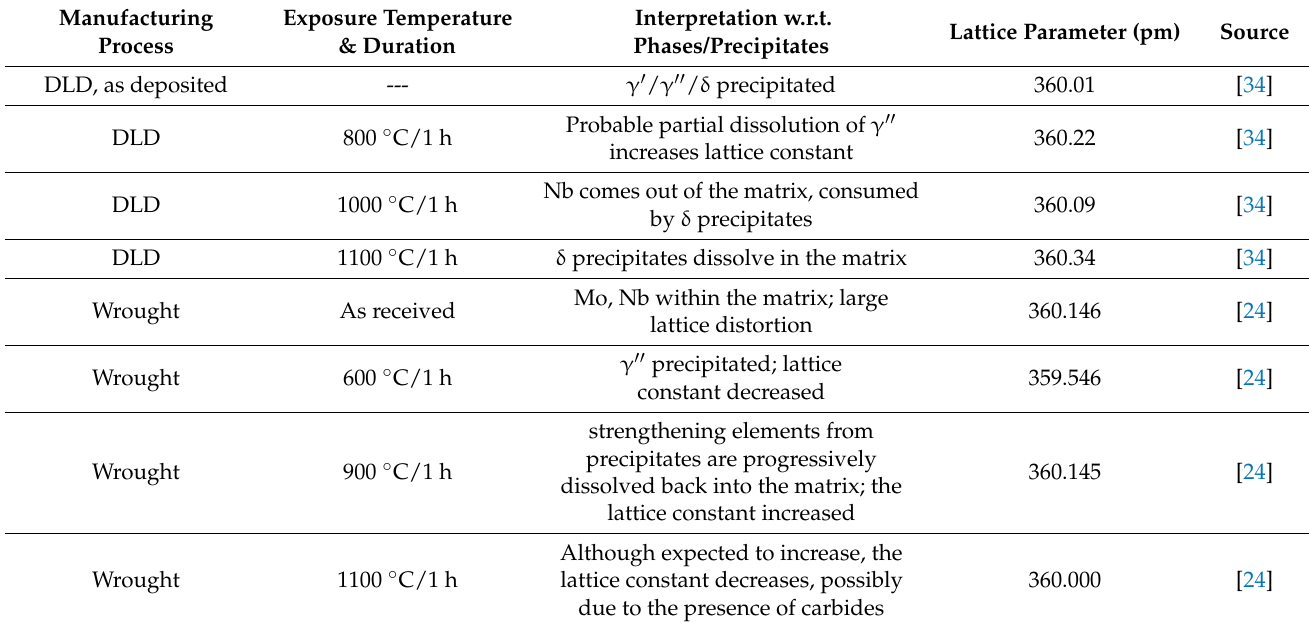
Table 1. Variation in the lattice parameter of the DLD and wrought Inconel 625 under different heat treatments.